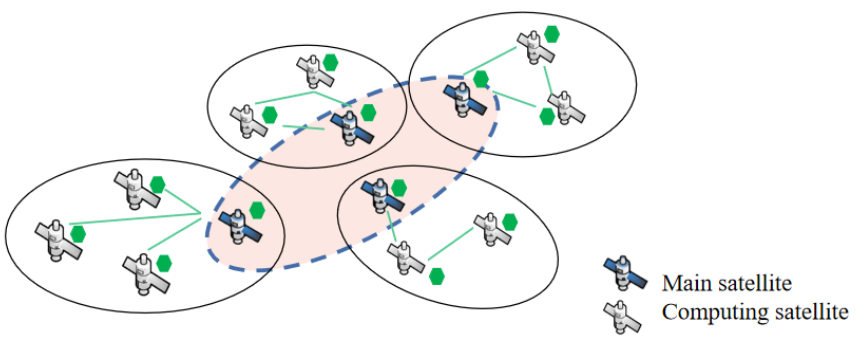
Figure 2. The collaborative fashion in the main satellites and computing satellites, where the main satellites need to distribute tasks to computing satellites so that they can achieve collaborative com- puting between multiple